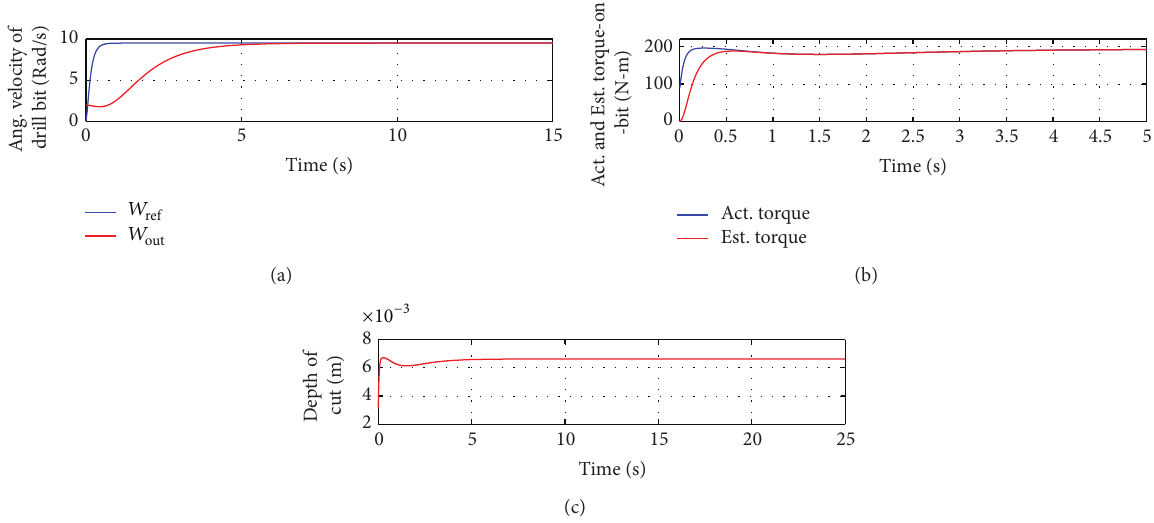
̂𝑇(𝑡) (b), and the depth of cut 𝑑(𝑡) (c)